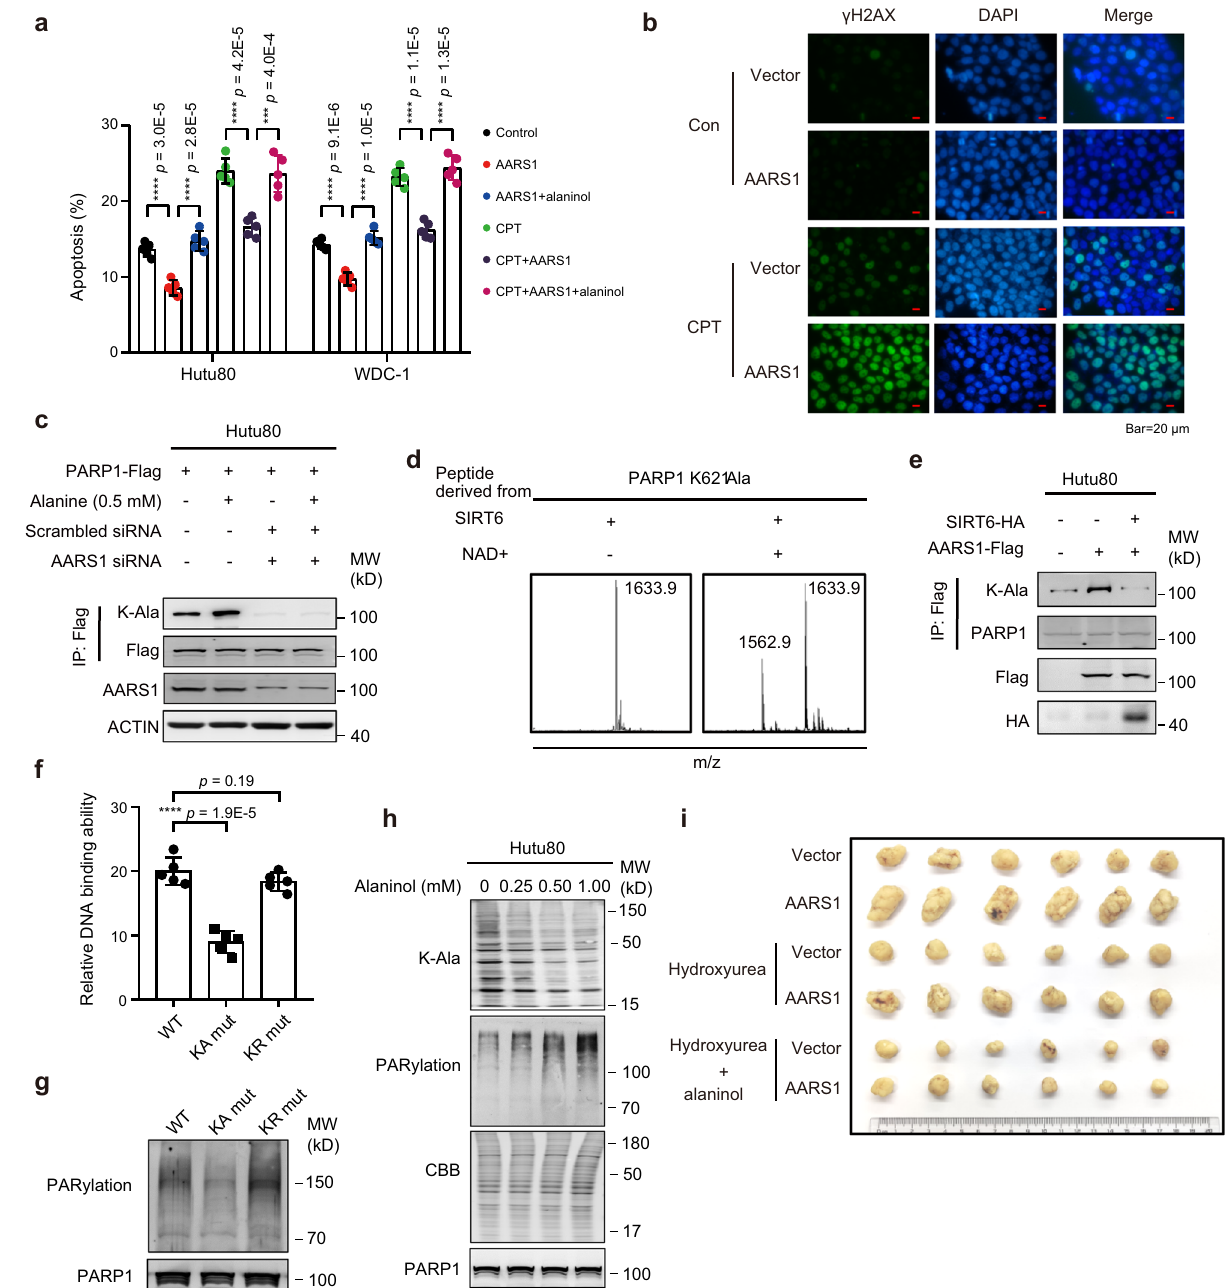
Fig. 7 | Lysine alanylation of PARP1 decreases cell apoptosis by inhibiting PARP1.a TheimpactsofAARSoverexpressing(OE)inHutu80cellsandWDC-1cells apoptosis ( n =5 repeats per group) (two-sided Student ’ s t -test, mean±SD): OE- AARS1, OE-AARS1-alaninol, CPT, OE-AARS1-CPT, and OE-AARS1-CPT-alaninol. CPT camptothecins. b Immuno fl uorescencestaining of γ H2AXwithvarioustreatments: OE-AARS1andOE-AARS1-CPT.Thescalebarindicates20 µ m. c TheeffectsofAARS1 and PARP1 on K-Ala levels. d The capacity of SIRT6 to dealanylate the synthetic